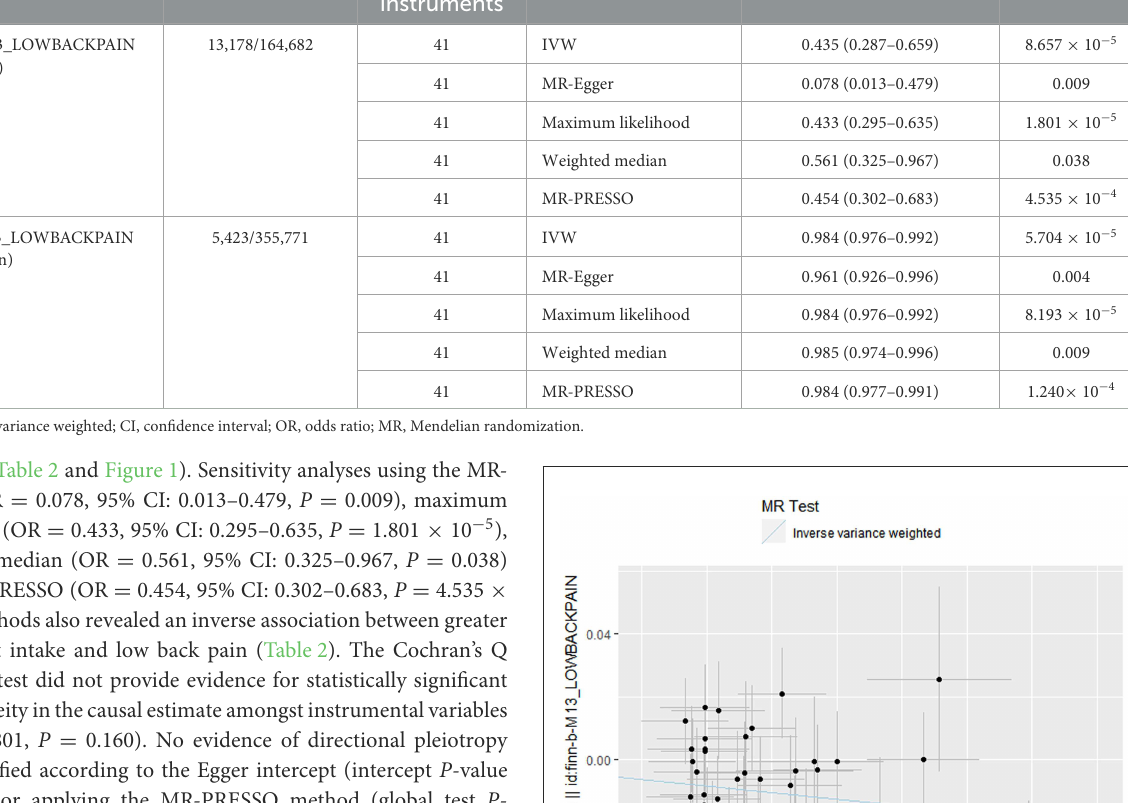
TABLE 2 MR analysis for the association between dried fruit intake and low back pain. Dataset for low back pain